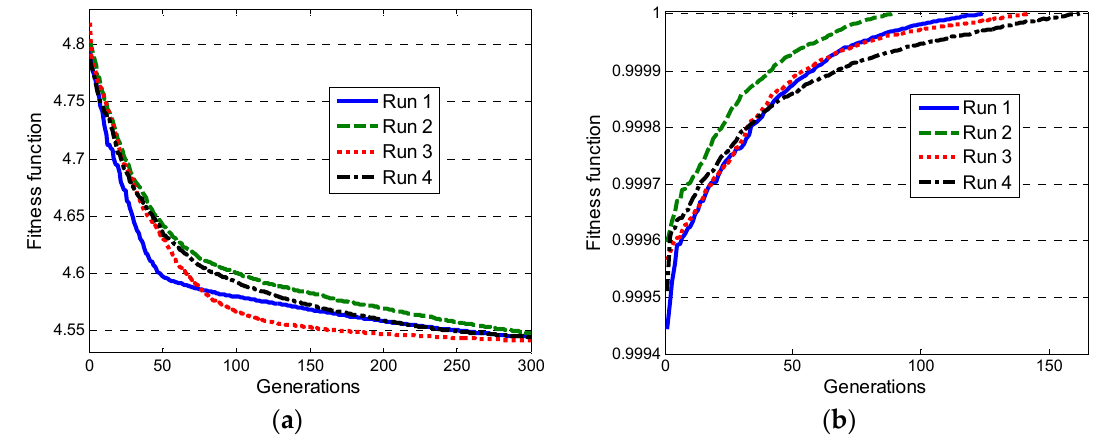
Figure 6. Convergence curves for ( a ) F f 1 and ( b ) F f 2 considering four independent runs (IEEE 30 bus power system).